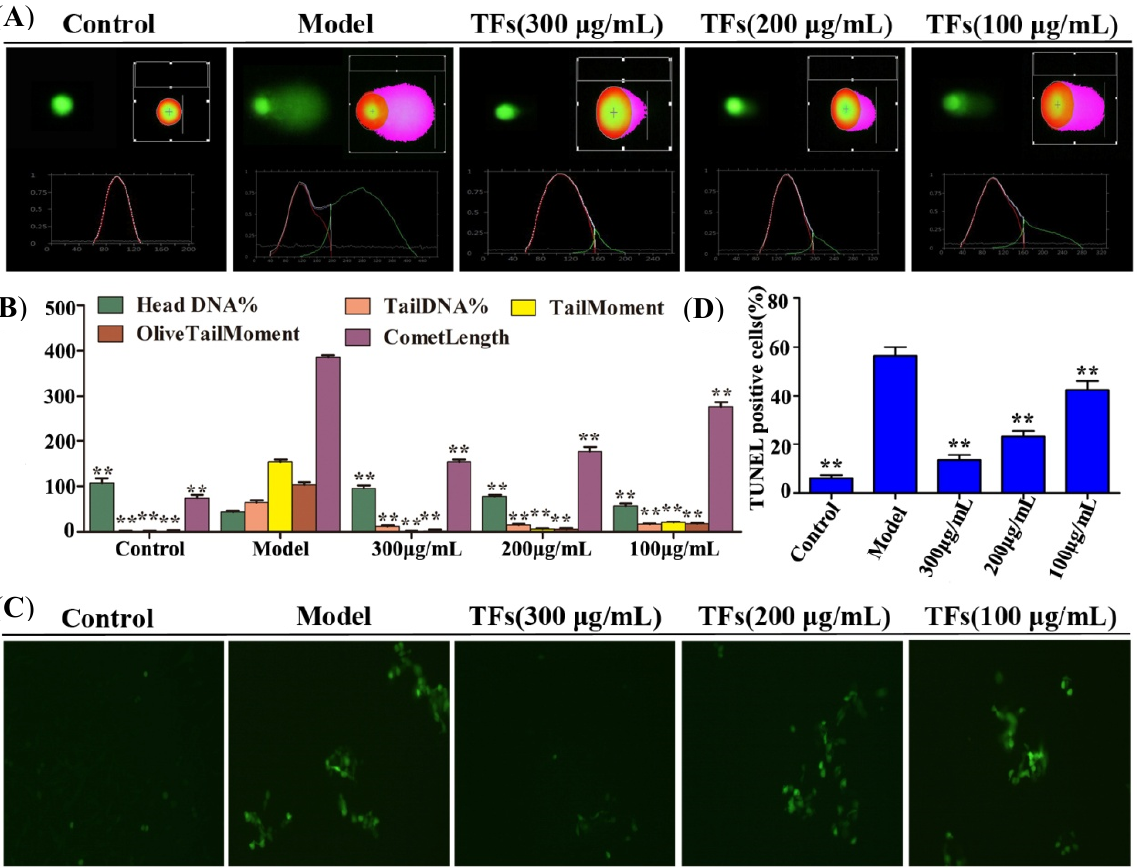
Figure 3. ( A ) The fluorescence images of comet assay photographed by fluorescence microscope (200×, final magnification); ( B ) The data of comet assay; ( C ) TUNEL AI (%) = (TUNEL positive cells/total cells) × 100. ( D ) The number of TUNEL-positive cells per field. Data are presented as mean ± SD ( n = 5). * p < 0.05 and ** p < 0.01 compared with model